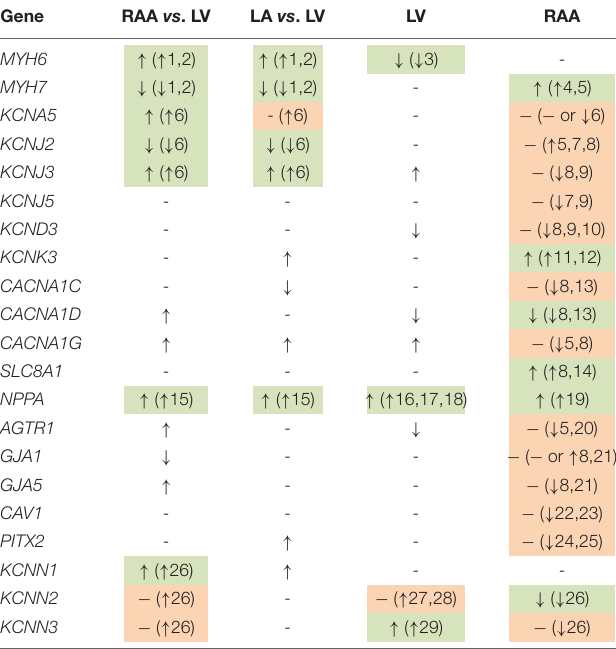
TABLE 2 | Summary of differential gene expression for all genes in this